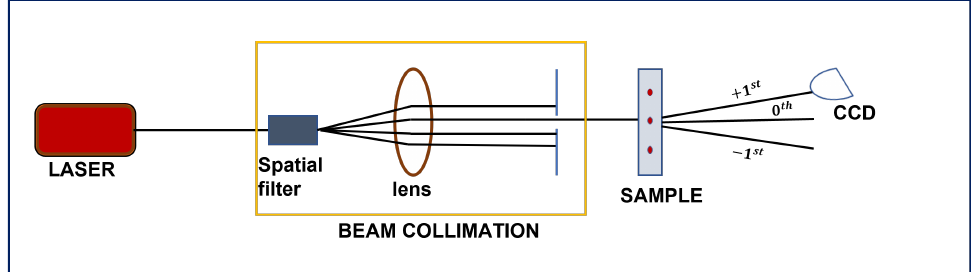
Figure 8. Optical setup for reconstruction of printed hologram on azocarbazole polymer